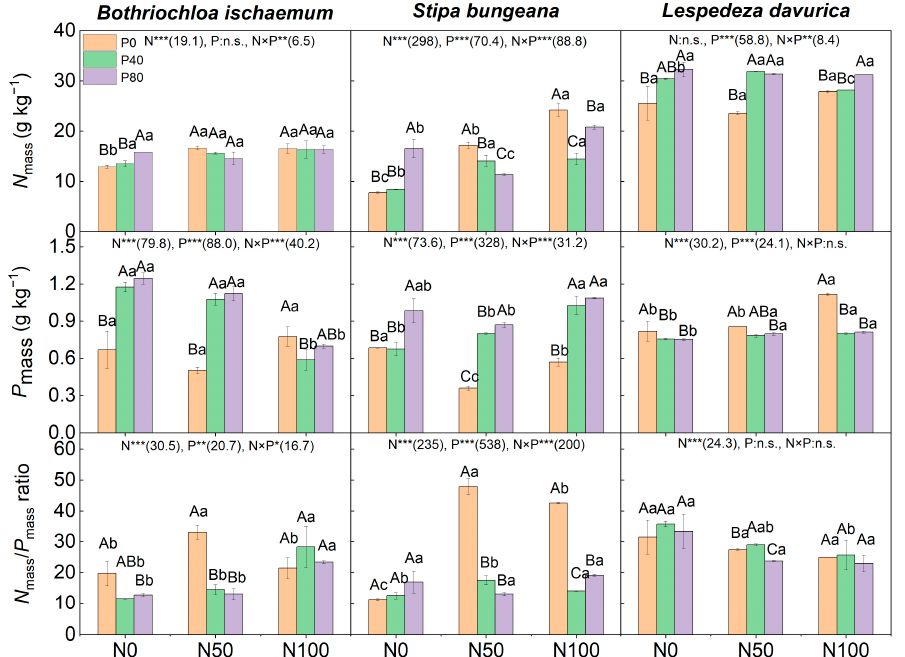
Figure 5. Leaf nitrogen (N) and phosphorus (P) content ( N mass and P mass ), as well as the N mass / P mass ratio, of the three species under different N and P addition treatments. Values are mean ± SD. Different capital letters above the column indicate significant differences among P additions under each N addition rate, while different small letters indicate significant differences among N additions under each P addition rate. Numbers in parentheses are F -values, while ‘*’, ‘**’, and ‘***’ indicate p ≤ 0.05, p ≤ 0.01, and p ≤ 0.001, respectively. ‘n.s.’ indicates no significant difference. N addition, alone, significantly affected the N mass /P mass ratios of all three species. The low level of N addition alone (N50P0) significantly increased the N mass /P mass of the two grasses; the high level of N addition, alone (N100P0), only increased the N mass /P mass of S. bungeana grass ( p < 0.05, Figure 5). N and P addition interaction significantly affects the N mass /P mass of the two grasses but has no effect on the subshrub. Under the addition of N50 combined with P, the N mass / P mass of B. ischaemum and S. bungeana decreased significantly, while the N mass /P mass of L. davurica increased under N50P40 treatment ( p < 0.05). Under the addition of N100 combined with P, the N mass / P mass of S. bungeana decreased significantly, while the N mass /P mass of B. ischaemum and L. davurica had no significant changes (Figure 5). 2.5. Specific Leaf Area (SLA) and Leaf Dry Matter Content (LDMC) N addition, alone, significantly increased the SLA values of the three species, and the low level of N addition alone (N50P0) decreased the LDMC of the two grasses ( p < 0.05, Figure 6). P addition, alone, significantly increased SLA of L. davurica , while it had limited effects on the two grasses (Figure 6). N and P addition interaction significantly affected both the SLA and LDMC values of all three species. Under the addition of N50 combined with P, the SLA of B. ischaemum and L. davurica increased significantly ( p < 0.05), and the SLA of S. bungeana increased under N50P40, while it decreased significantly under N50P80 ( p < 0.05); LDMC was comparable between different levels of P additions in the two grasses, but it decreased in L. davurica . Under the addition of N100 combined with P,